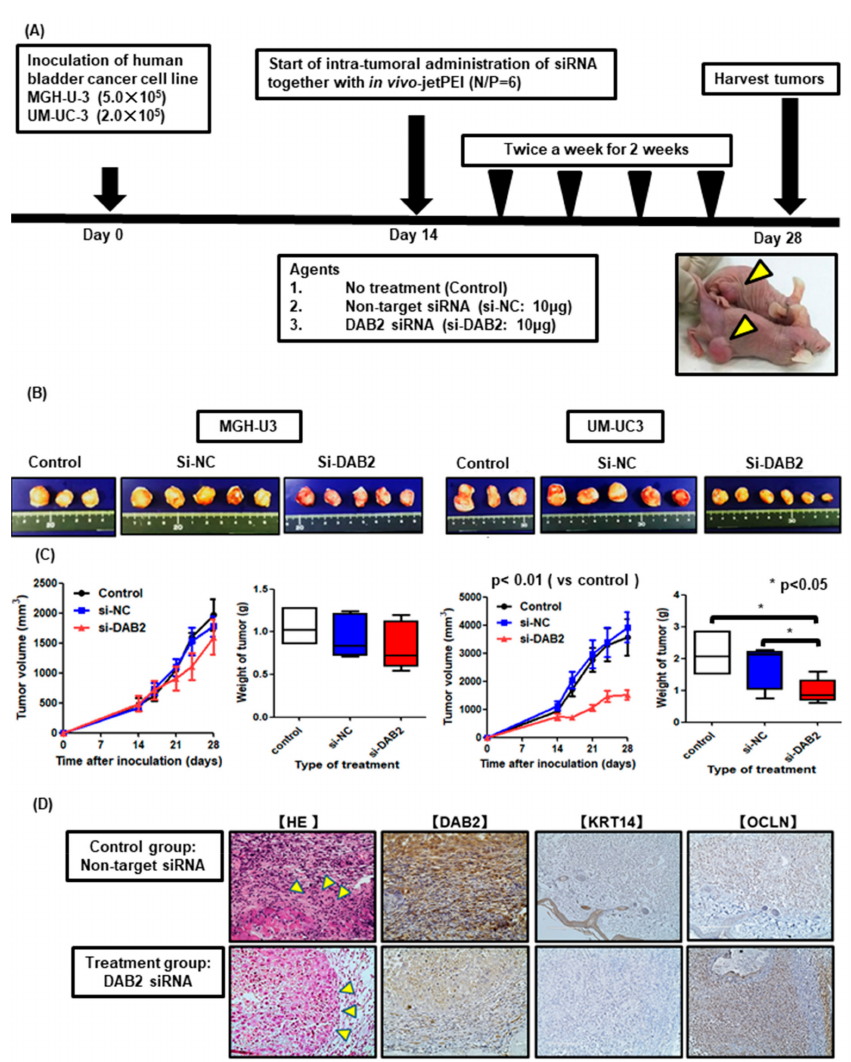
Figure 6. ( A ) Schematic drawings showing this experiment workflow. We injected mice with UM-UC-3 cells (2 × 10 5 / tumor) and MGH-U-3 cells (5 × 10 5 / tumor) together with Matrigel and divided them into three groups ( n = 3; control (no treatment), n = 5; negative control siRNA, and n = 5 or 6; human DAB2 siRNA) after two weeks. Then, we treated mice twice a week for 4 weeks. Three days after the last treatment, we euthanized mice and harvested xenografts. Yellow triangles show subcutaneous tumors. ( B ) These pictures were xenografts resected from treatment groups. ( C ) Tumor growth rate during treatment was significantly lower in UM-UC-3 mice treated with DAB2 siRNA compared to both the control and negative control siRNA group (Mann–Whitney U test; * = p < 0.05). Intratumoral treatment with DAB2 siRNA resulted in a significant weight loss of excised xenografts compared to both the control and negative control siRNA group (Mann–Whitney U test; * = p < 0.05). However, in MGH-U-3 mice, both tumor growth rates and resected tumor weights were not significantly different between groups. ( D ) Representative images of xenograft tumors stained for each marker in UM-UC-3 group cells. Yellow triangles indicate tumor infiltration in control group mice but not in treatment group